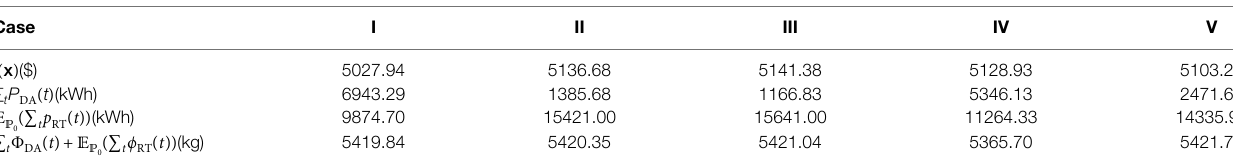
TABLE 1 | Simulation results under different